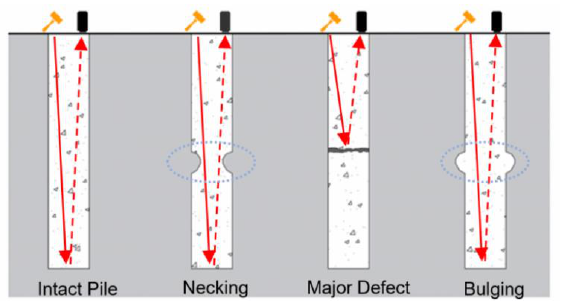
Figure 22. The principle of the PIT, possibilities and limits. By